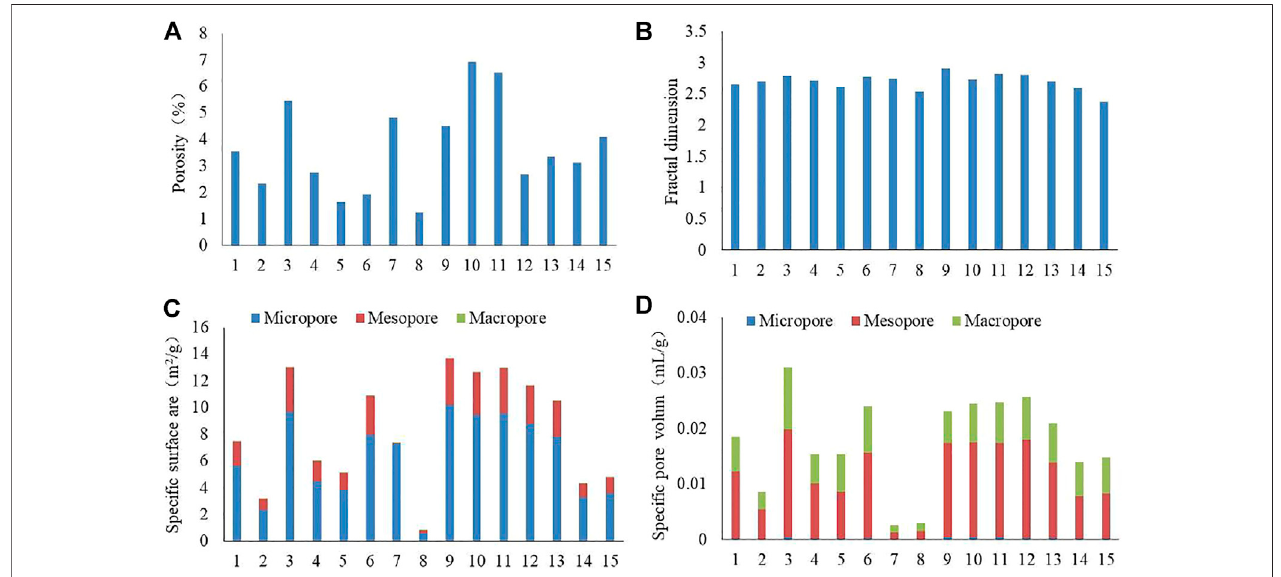
FIGURE 7 | Pore structure characteristic parameters of samples. (A) Porosity. (B) Fractal dimension. (C) Speci fi c surface area. (D) Speci fi c pore volume.